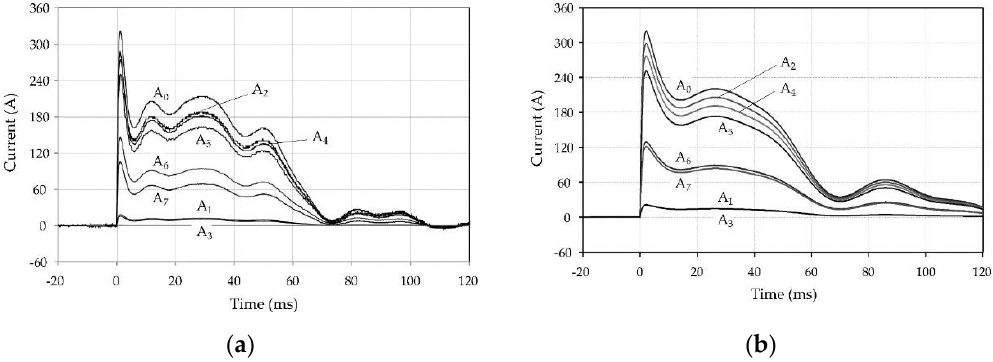
Figure 8. Waveshapes of 60 ms long impulse current measured in the tested object: ( a ) measured; ( b ) computed. The denotation of the measuring points, A 0 to A 7 , is consistent with Figure 1b.